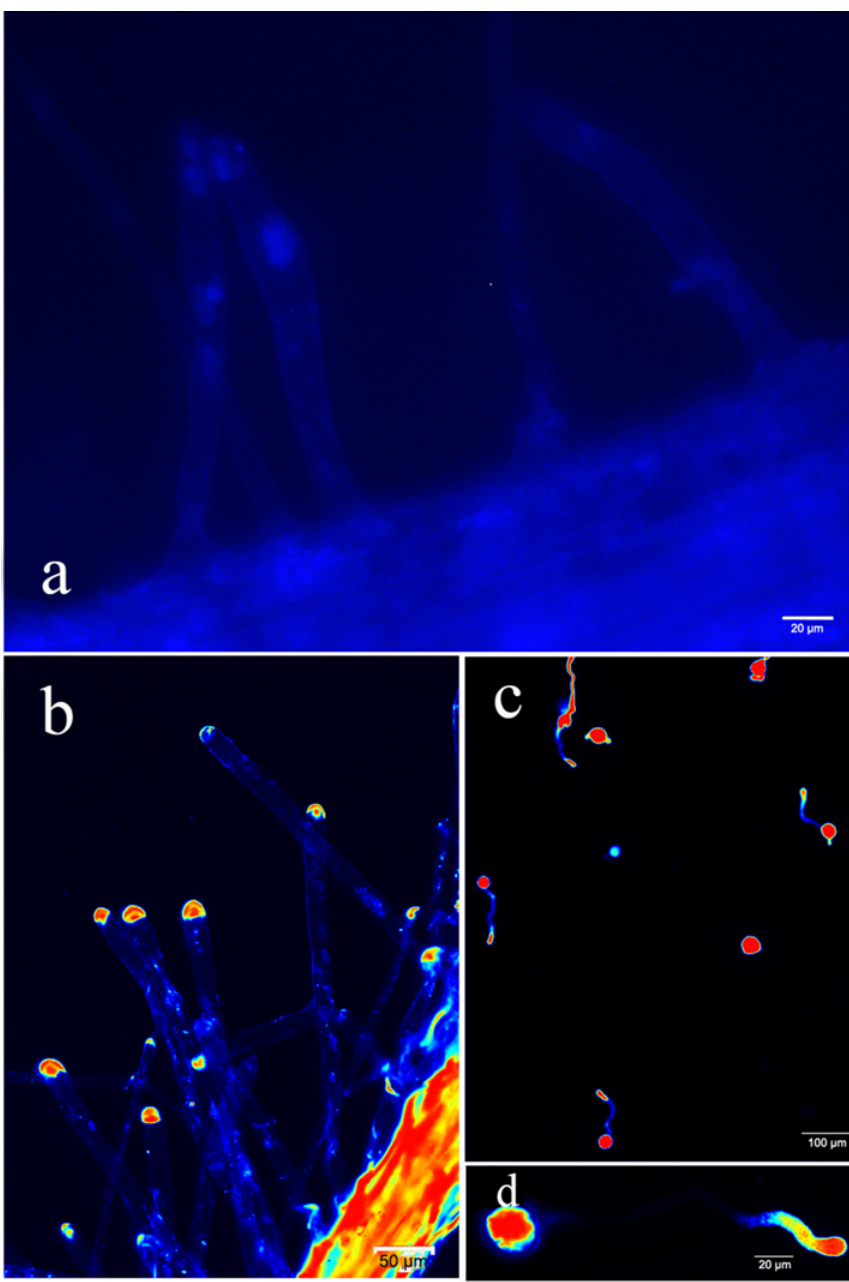
Fig 8. Loading fluo-4/AM into the root hair and pollen tube of Arabidopsis . (a) Control root hair that was not loaded with fluo-4/AM. (b) Root hair loaded with fluo-4/AM along with cell lysis solution for 15 min. (c-d) Pollen tubes loaded with fluo-4/AM along with cell lysis solution for 15 min. Note: The root hairs were barely observable in the fluorescence microscopy image because the autofluorescence of the root hairs was very weak. To see the root hairs clearly in the image, we improved the overall image brightness with Photoshop software. Therefore, the background of image (a) is different from the background of the other images (b, c and